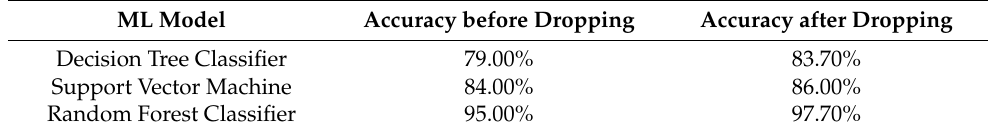
Table 8. Results of accuracy of machine learning models after dropping low-importance